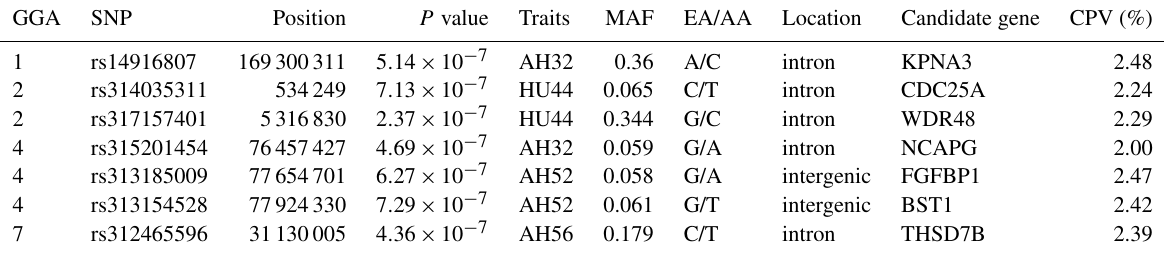
Table 4. SNP markers with significant effects on albumen quality by univariate genome-wide association study. GGA